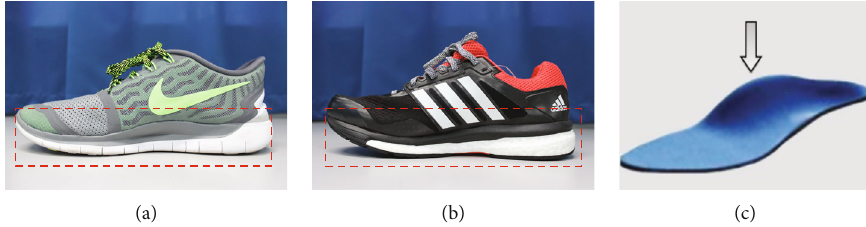
Figure 2: Pro fi le of running shoes used in the experiment: (a) minimal shoe (MS), (b) heeled shoe (HS), and (c) sole pro fi le of